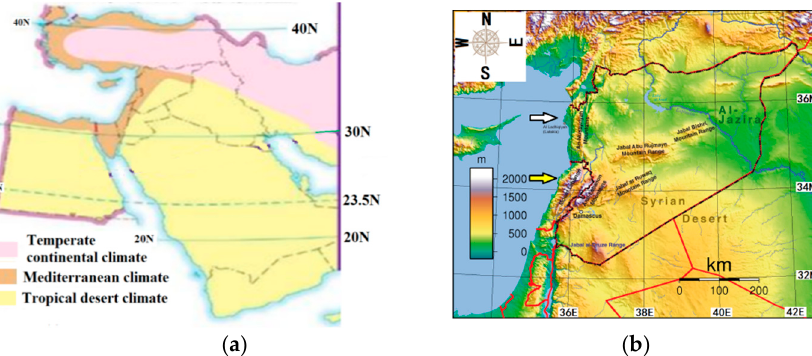
Figure 1. The Middle East climate regions and topography. ( a ) The climate zone divisions; and ( b ) topography. The white and yellow arrows indicate the north and south coastal mountains.